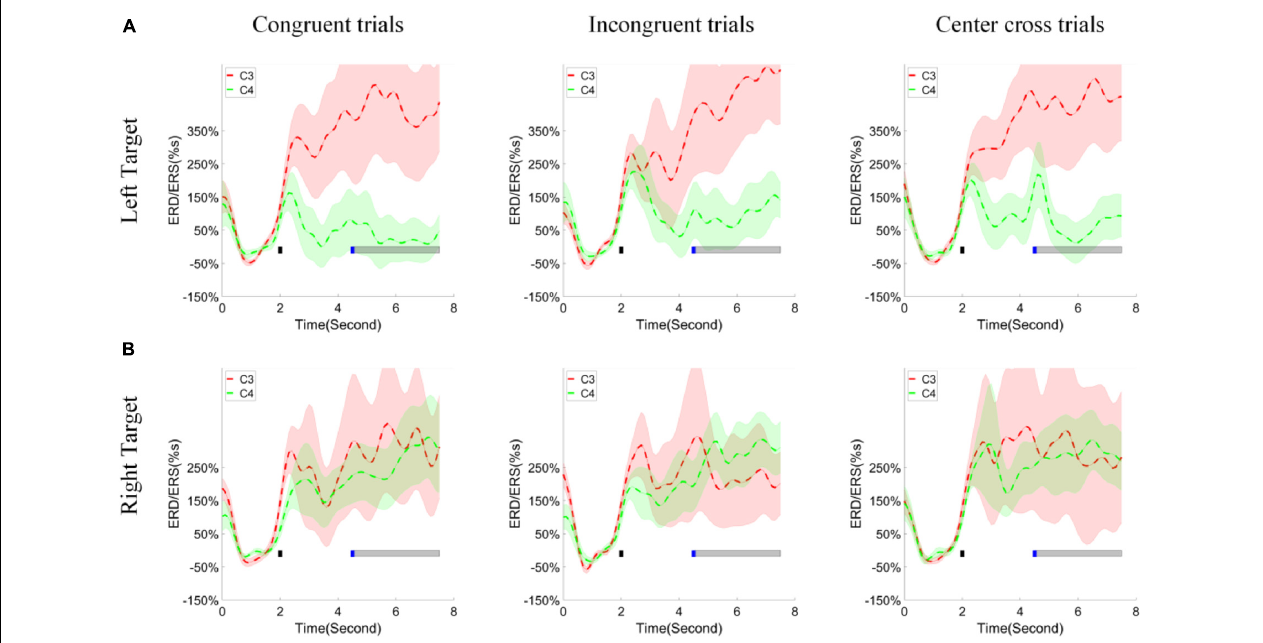
FIGURE 8 | ERD/ERS values and statistics. (A) The group average of time varying ERD/ERS values for the left hand task (the upper row) and (B) right hand task (the bottom row) over fourteen subjects. The columns separated the results for congruent trials, incongruent trials and center cross trials, respectively. The target cue appeared at the end of second 2, which was indicated by a short black bar. The cursor feedback began at the second of 4.5, which was marked by a short blue bar. The light gray bar represented the feedback